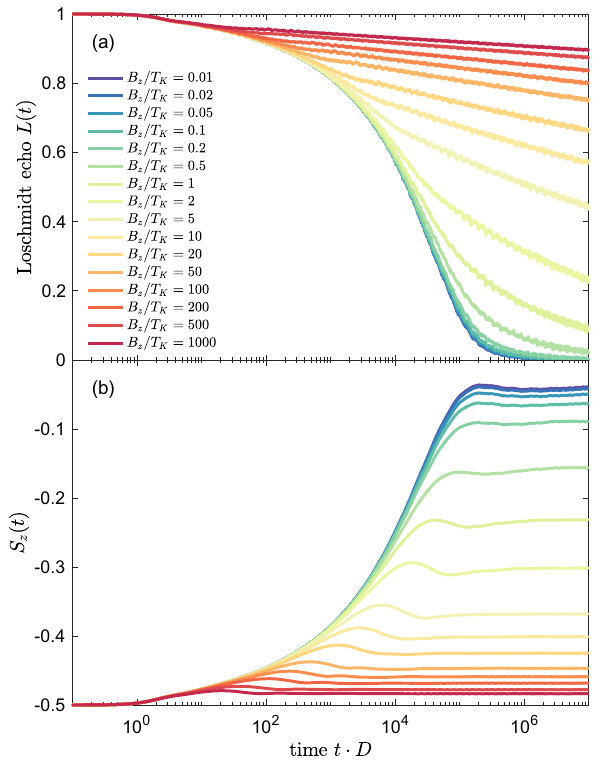
Figure 5. The time-evolution of ( a ) the Loschmidt echo and ( b ) spin expectation value calculated for quantum quench in J 1 ≡ J , starting from J = 0 to J = 0.2 , while J 2 = 0 , for different values of magnetic field B z , as listed in the legend. The magnetic field is expressed in units of the Kondo temperature for J = 0.2 , T K = 4 · 10 − 5 . The other parameters are the same as in Fig.